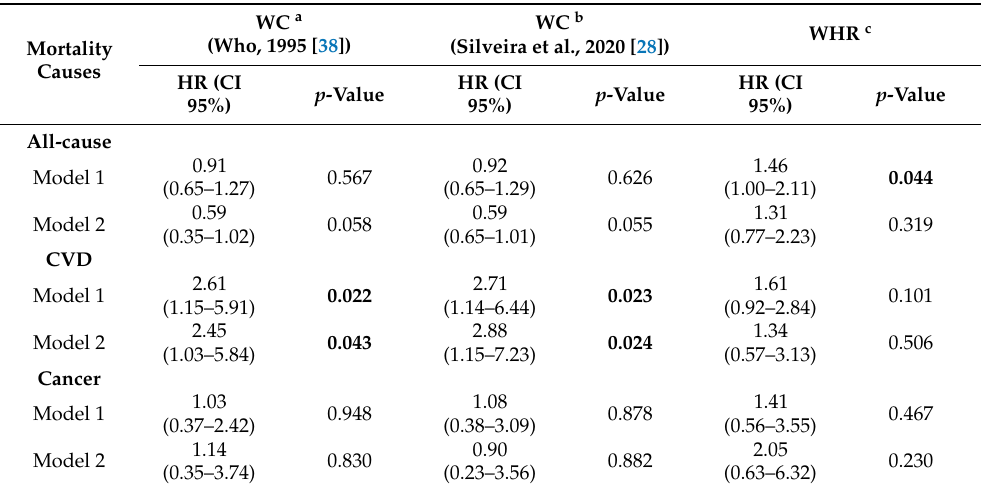
Table 3. Multivariate Cox regression for the association between abdominal obesity indicators and of all-cause, CVD and cancer mortality risk.